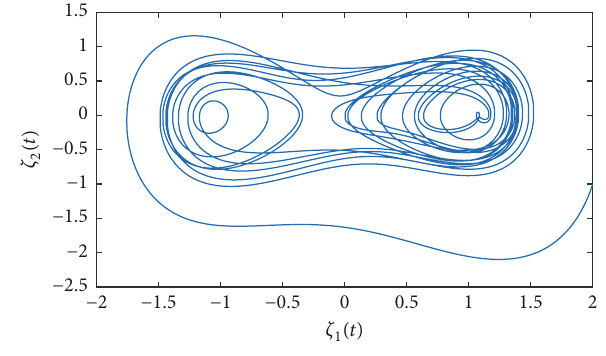
Figure 1: Phase attractor of FOCS